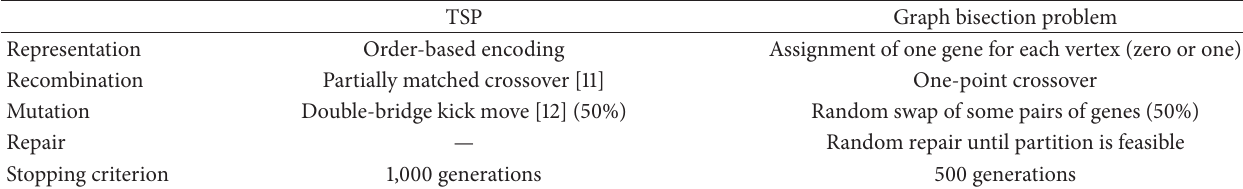
Table 1: Genetic parameter settings.